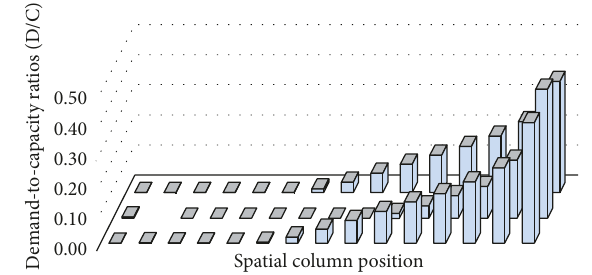
Figure 12: Demand to capacity ratios D/C: uneven distribution of inelastic response, CM placed with 14% of eccentricity in order to obtain δ max / δ avg 1.4 in the equivalent linear static analysis. (cid:31)